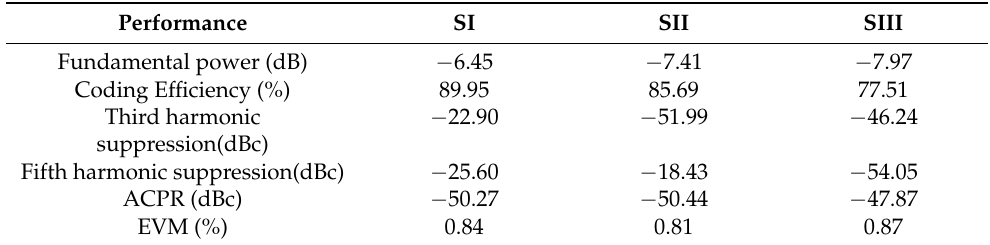
Figure 9. Simulated spectrum of SI, SII and SIII for the 16QAM input signal at 200 MHz carrier with T r = 1%. Table 2. Performance Comparison for SI, SII and SIII under the 16QAM Input Signal at 200 MHz Carrier with T r =